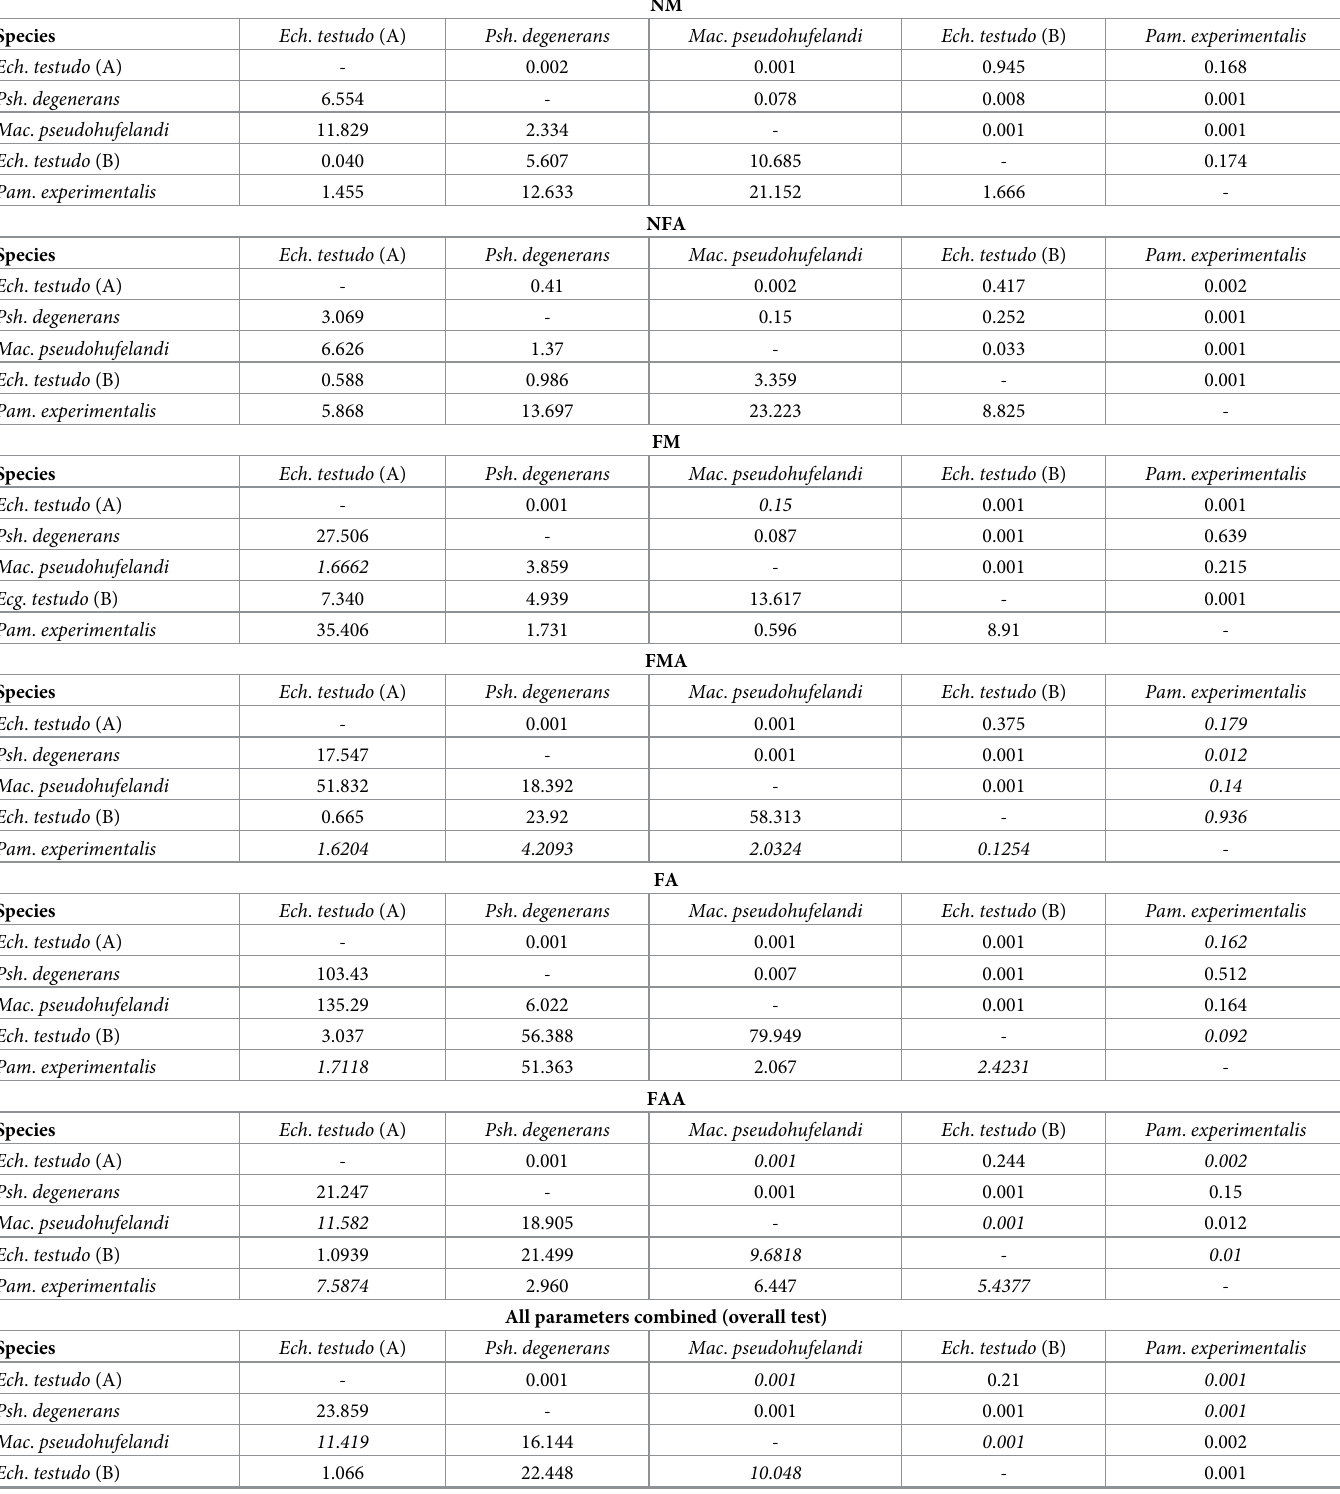
Table 3. Differences in the applied activity measures and the measures combined between pairs of